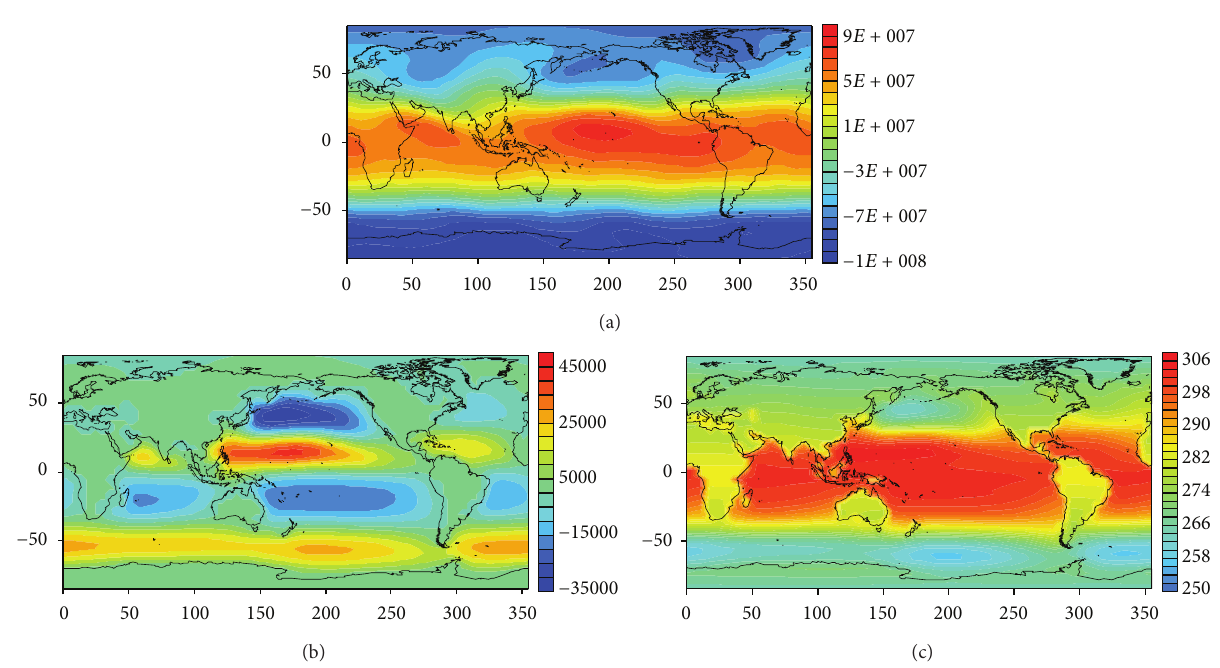
Figure 7: Annual mean of (a) atmospheric stream function (unit: m 2 s −1 ), (b) oceanic stream function (unit: m 2 s −1 ), and (c) sea surface temperature and land surface temperature (unit: K).